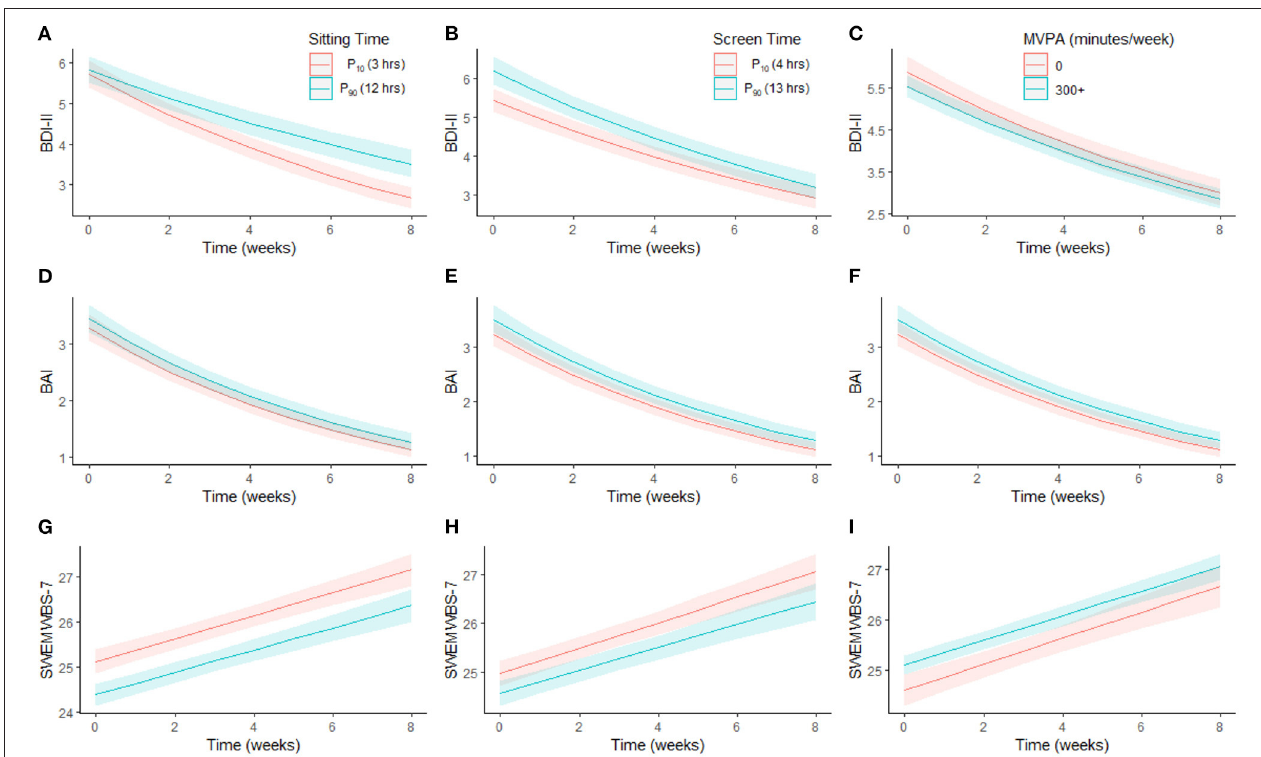
FIGURE 1 | Association between changes in mental health over time by sitting time, screen time, and MVPA. Marginal effects plot showing trajectories in depressive symptoms (A–C) , anxiety symptoms (D–F) and positive mental health (G–I) over time by each exposure (sitting time, screen time, and MVPA), holding covariates at their mean (for continuous variables) or proportions (for factor variables). BAI, Beck Anxiety Inventory; BDI-II, Beck Depression Inventory II; MVPA, moderate-to-vigorous physical activity; SWEMWBS-7, Short Warwick-Edinburgh Mental Well-being